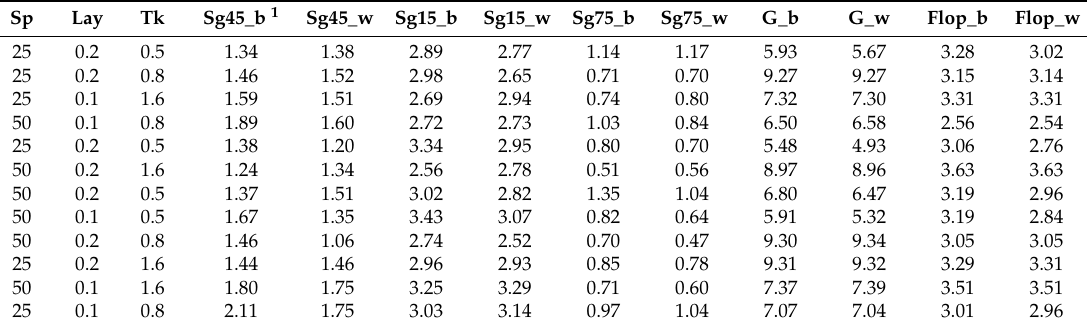
Table 1. Results of the PLA (poly(lactic acid)) samples when changing printing parameters: printing speed (Sp), layer height (Lay), sample thickness (Tk). Sparkle (Sg), graininess (G) and flop were measured. The sparkle measurements were taken at di ff erent geometries (15 ◦ , 45 ◦ and 75 ◦ ) on the white (w) and black (b)